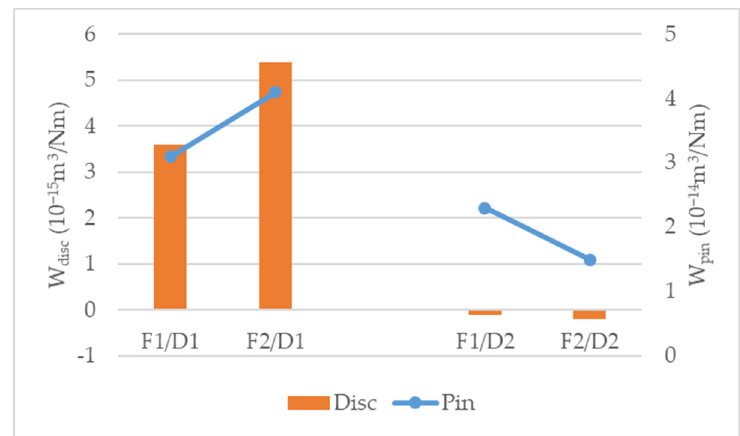
Figure 7. Mean specific wear rate of friction pairs in contact; F1 and F2 represent low-metallic friction material and nano-TiO 2 embedded friction material respectively, whereas D1 and D2 represent GCI disc and HVOF WC-10Co-4Cr coated disc respectively, adopted from Wahlström et al.